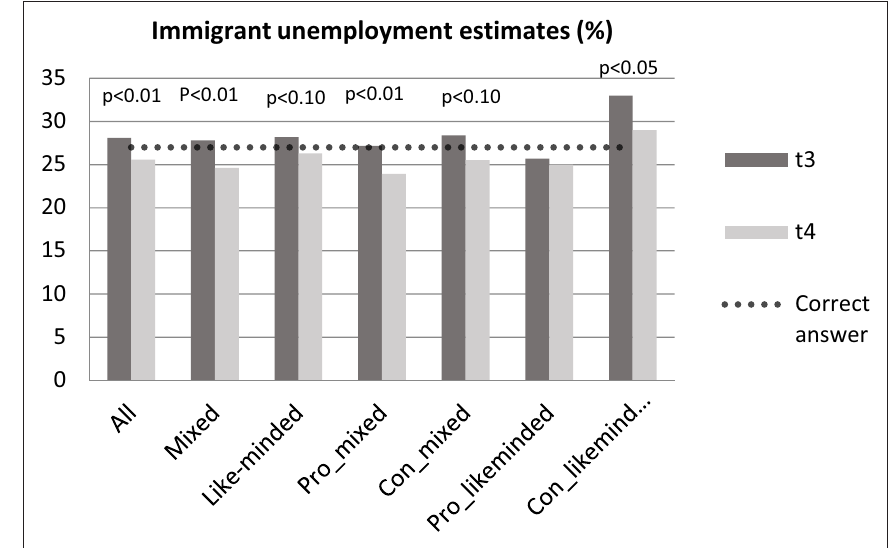
Figure 1: Estimates for unemployment (%) among immigrants measured before (t3) and after deliberation (t4); p-values indicate significant change in